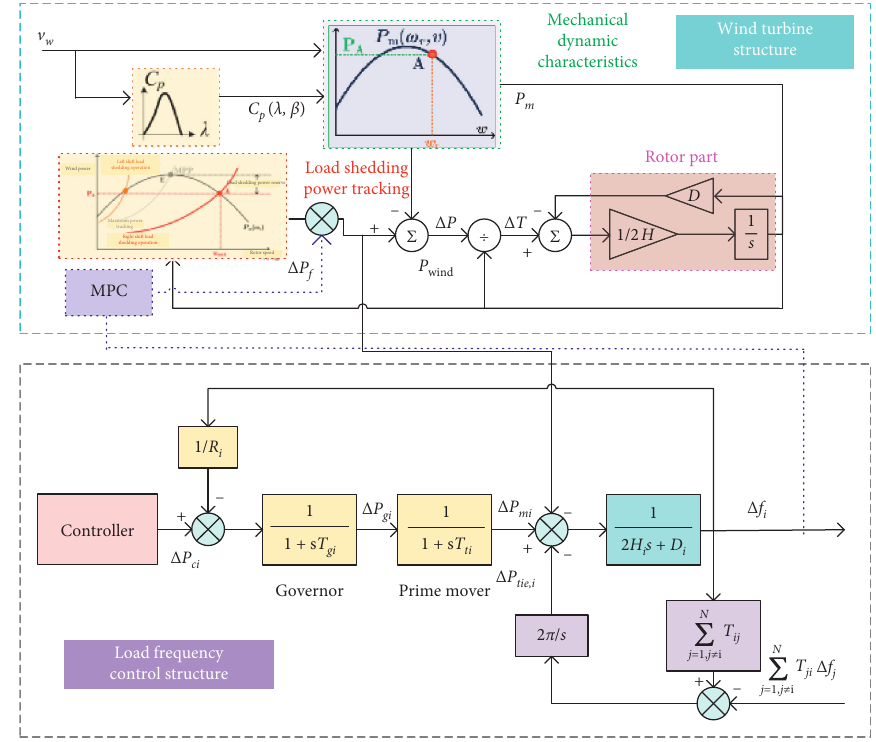
Figure 3: Frequency response model block diagram of wind turbine active participation in microgrid frequency